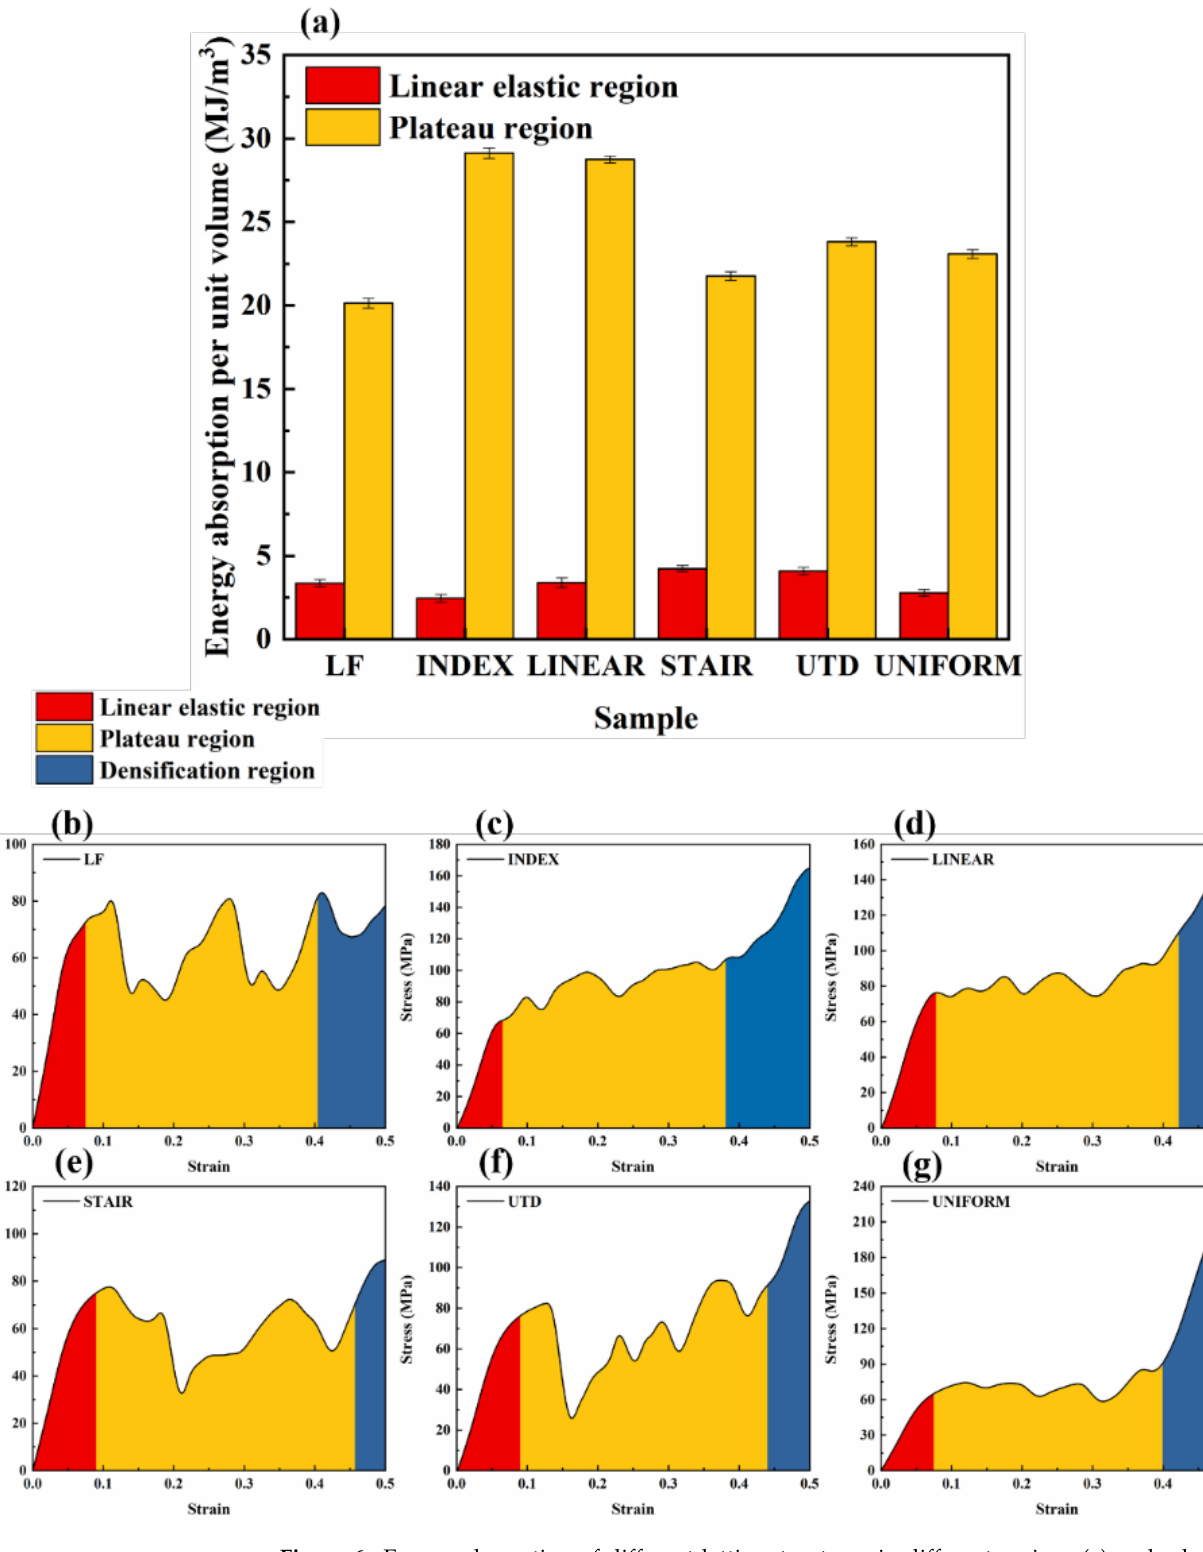
Figure 6. Energy absorption of different lattice structures in different regions ( a ) and schematic diagrams of the three deformation regions for different lattice structures ( b – g ).